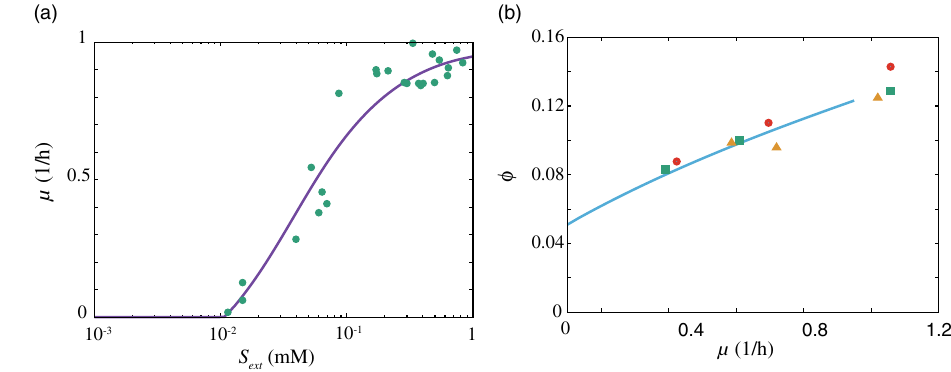
FIG. 6. Comparison of the model results using estimated values (Table II) with experimental values. (a) The specific growth rate is plotted as a function of the external substrate (glucose) concentration. Experimental data are adopted from Monod [1]. (b) Ratio of ribosomal proteins (component A) to total proteins as a function of the specific growth rate: Orange triangles are from Scott et al. [4], red circles are from Bremer and Dennis [48], and green squares are from Forchhammer et al. [49]. In panel (b), the theoretical curve from the model is plotted up to about 1.0 because we obtained the parameter values by fitting the μ − ϕ relation and the Monod equation with ∼ 1 . 0 the maximum growth rate of μ max